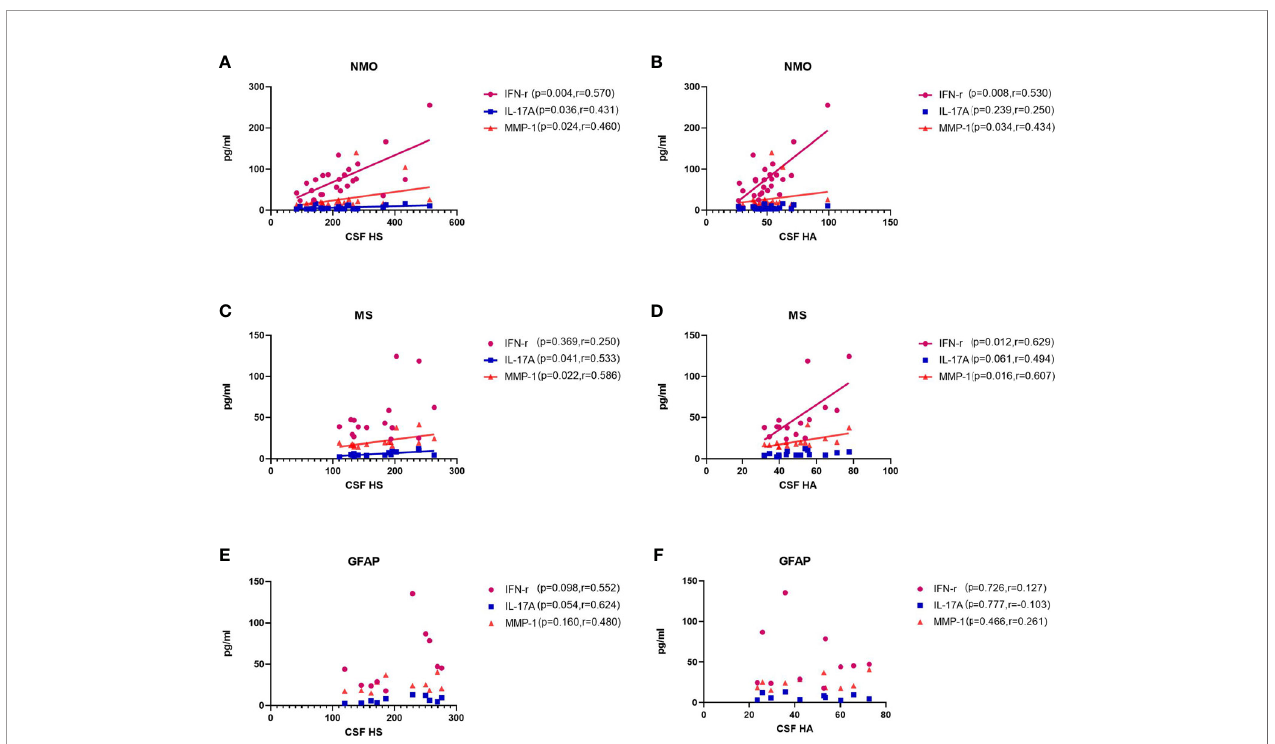
FIGURE 3 | Correlations between the CSF levels of HA and HS and CSF levels of IFN g , IL17, and MMP1 in patients with NMO, MS and autoimmune GFAP astrocytopathy. (A, B) In NMO, the CSF levels of HS were positively correlated with IFN g and MMP1, while the CSF levels of HA was positively correlated with MMP1. (C, D) In MS, the CSF levels of HS were positively correlated with MMP1, while the CSF levels of HA was positively correlated with IFN g . (E, F) In autoimmune GFAP astrocytopathy, the CSF levels of HS were positively correlated with MMP1, while the CSF levels of HA was positively correlated with IL17. The p and r- values are indicated within each